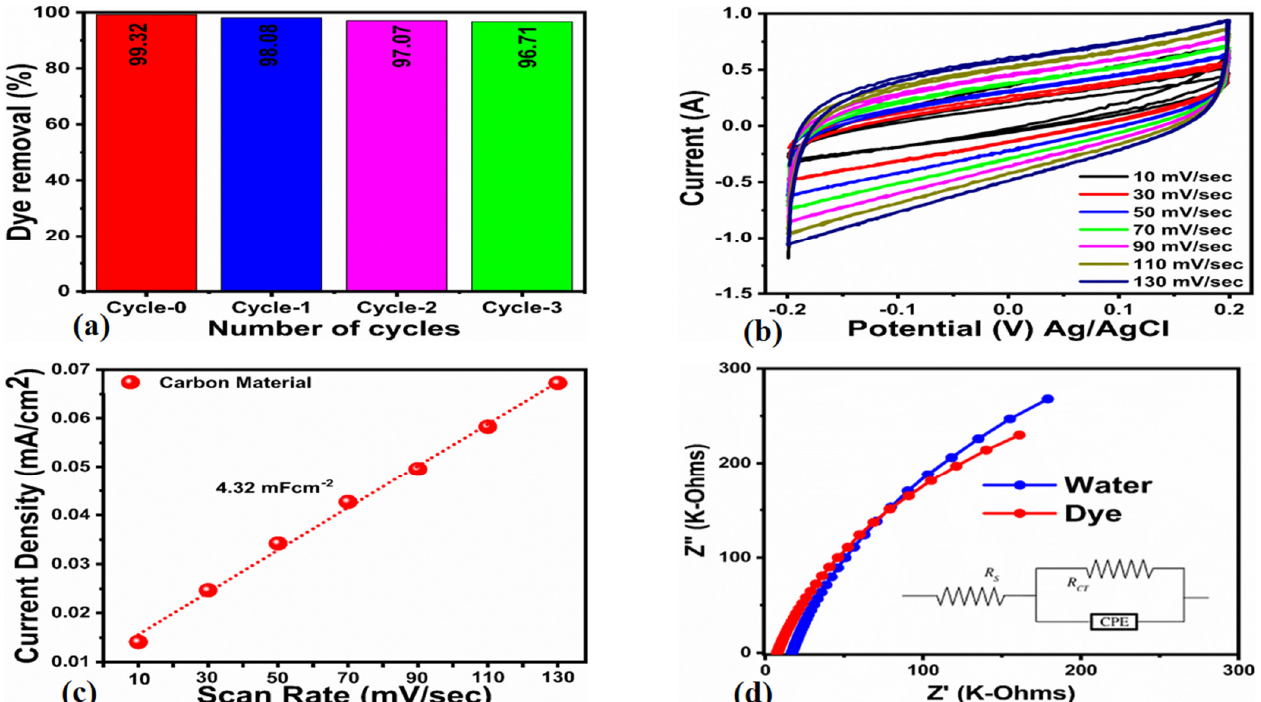
Figure 8. ( a ) Reusability of three cycles measured in 2.3 × 10 −5 M MB solution. ( b ) Cyclic voltammetry measured in 2.3 × 10 −5 M MB solution at various scan rates. ( c ) Linear fitting of difference anodic and cathodic current density for measuring (ECSA). ( d ) EIS measurement in 2.3 × 10 −5 M MB solution and bare water under the irradiation of UV light at a sweeping frequency rate of 100 kHz to 0.1 Hz, an amplitude of 10 mV and zero bias potential in open circuit.